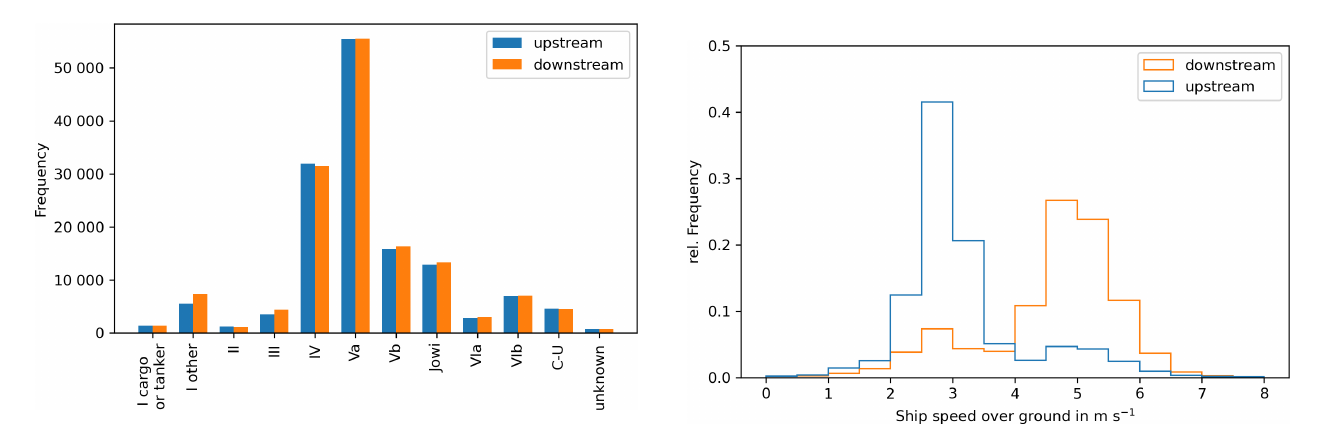
Figure 7. Ship speed over ground for all ship passages identified at DURH as a function of direction of